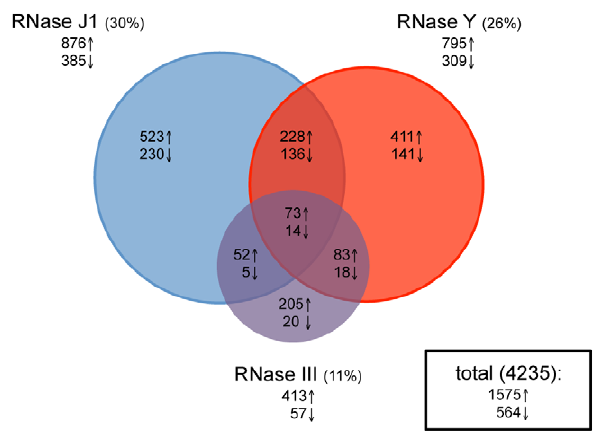
Figure 2. Effects of RNase J1, Y, and III depletion on abundance of B.subtilis mRNAs. The Venn diagram shows the number of mRNAs (open reading frames) altered in each of the three mutant strains CCB034 (RNase J1), CCB294 (RNase Y) and CCB288 (RNase III). Upward pointing arrows indicate the number of mRNAs showing increased abundance; downward pointing arrows indicate decreased abundance. The areas of the circles are proportional to the number of mRNAs showing altered abundance in each strain. The total number of mRNAs affected in the experiment is shown in the rectangle to the right of the Venn